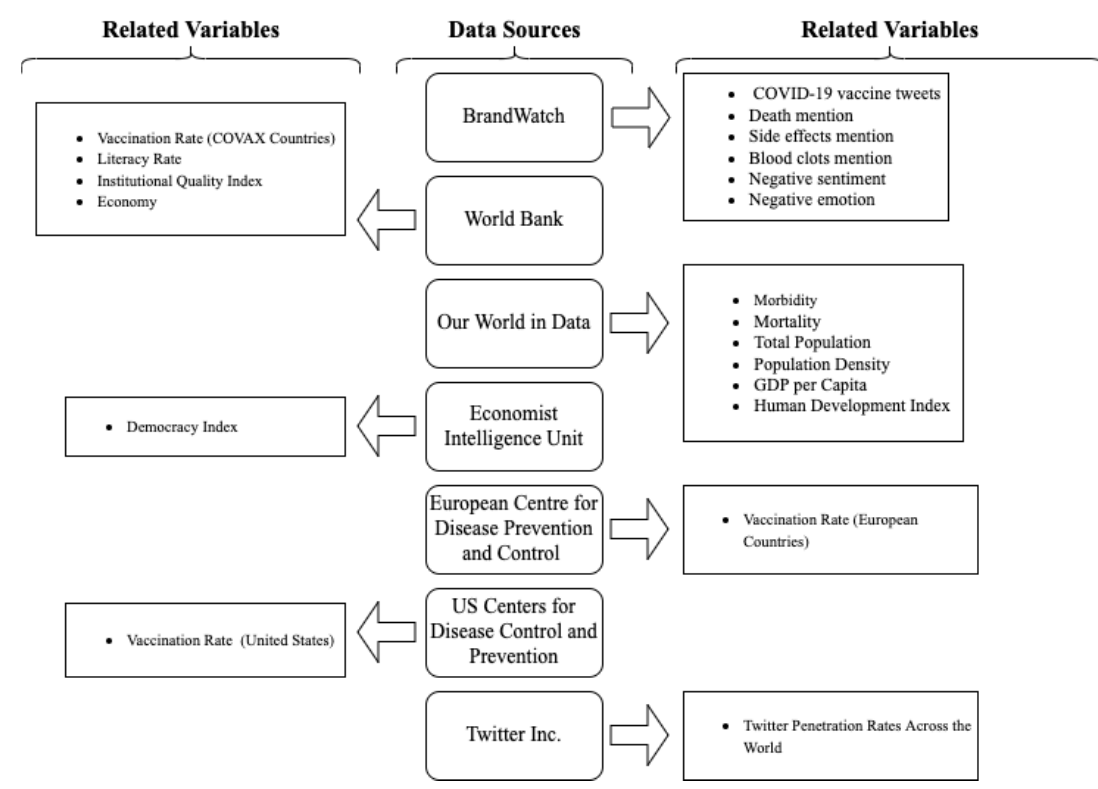
Figure A1. Study variables and data sources.